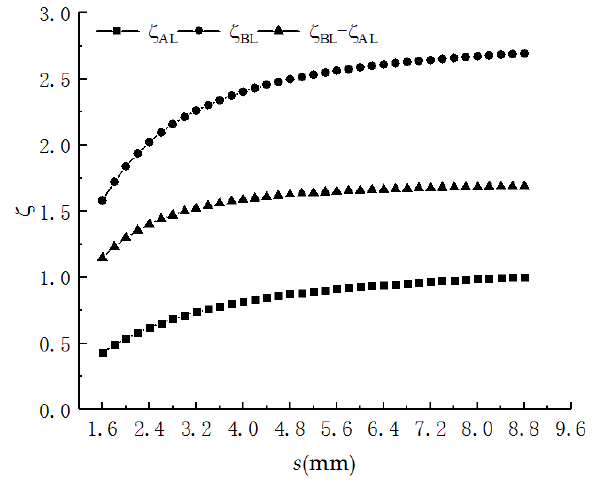
Figure 4. The theoretically calculated results of ζ AL , ζ BL and ( ζ BL − ζ AL ) .